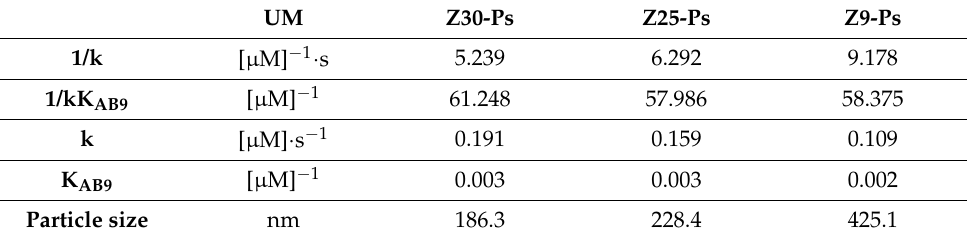
Table 3. Relation between particle size and kinetic constant. The particle size and related surface area play a significative role in